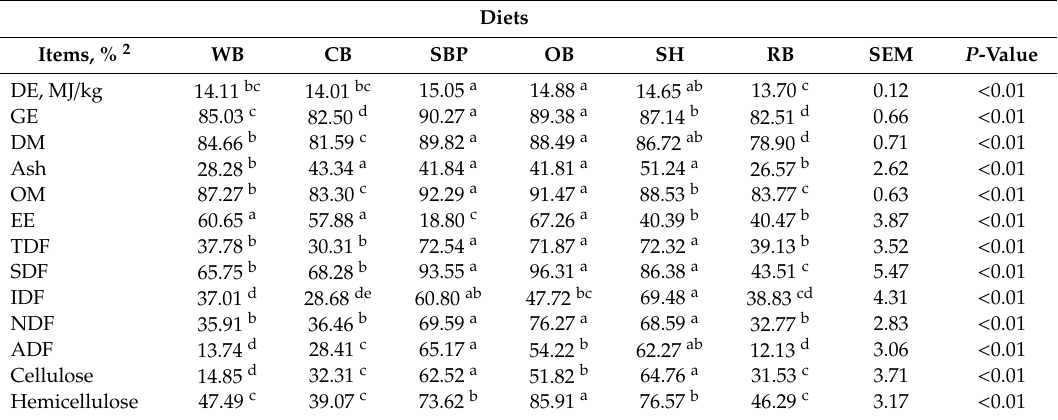
Table 4. The apparent total tract digestibilities (ATTDs) of chemical components for pigs fed diets with di ff erent high-fiber ingredients 1